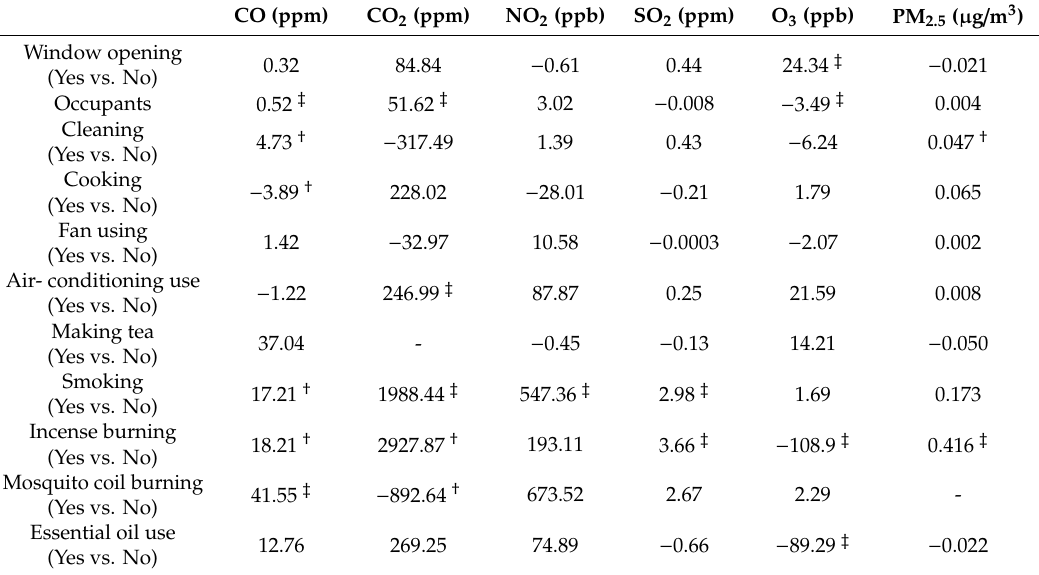
Table 5. Association between air pollutants concentrations (24-h average concentration of air pollutants in each house as dependent variable), and household characteristics: generalized estimating